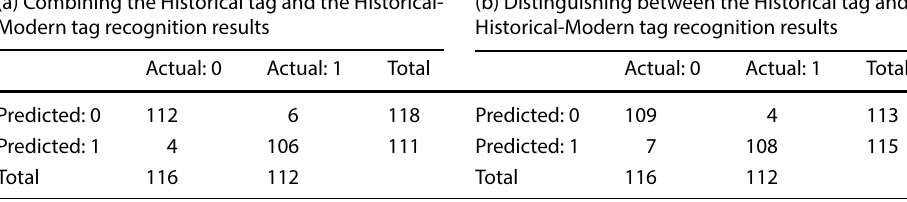
Table 2 Test results of the object detection